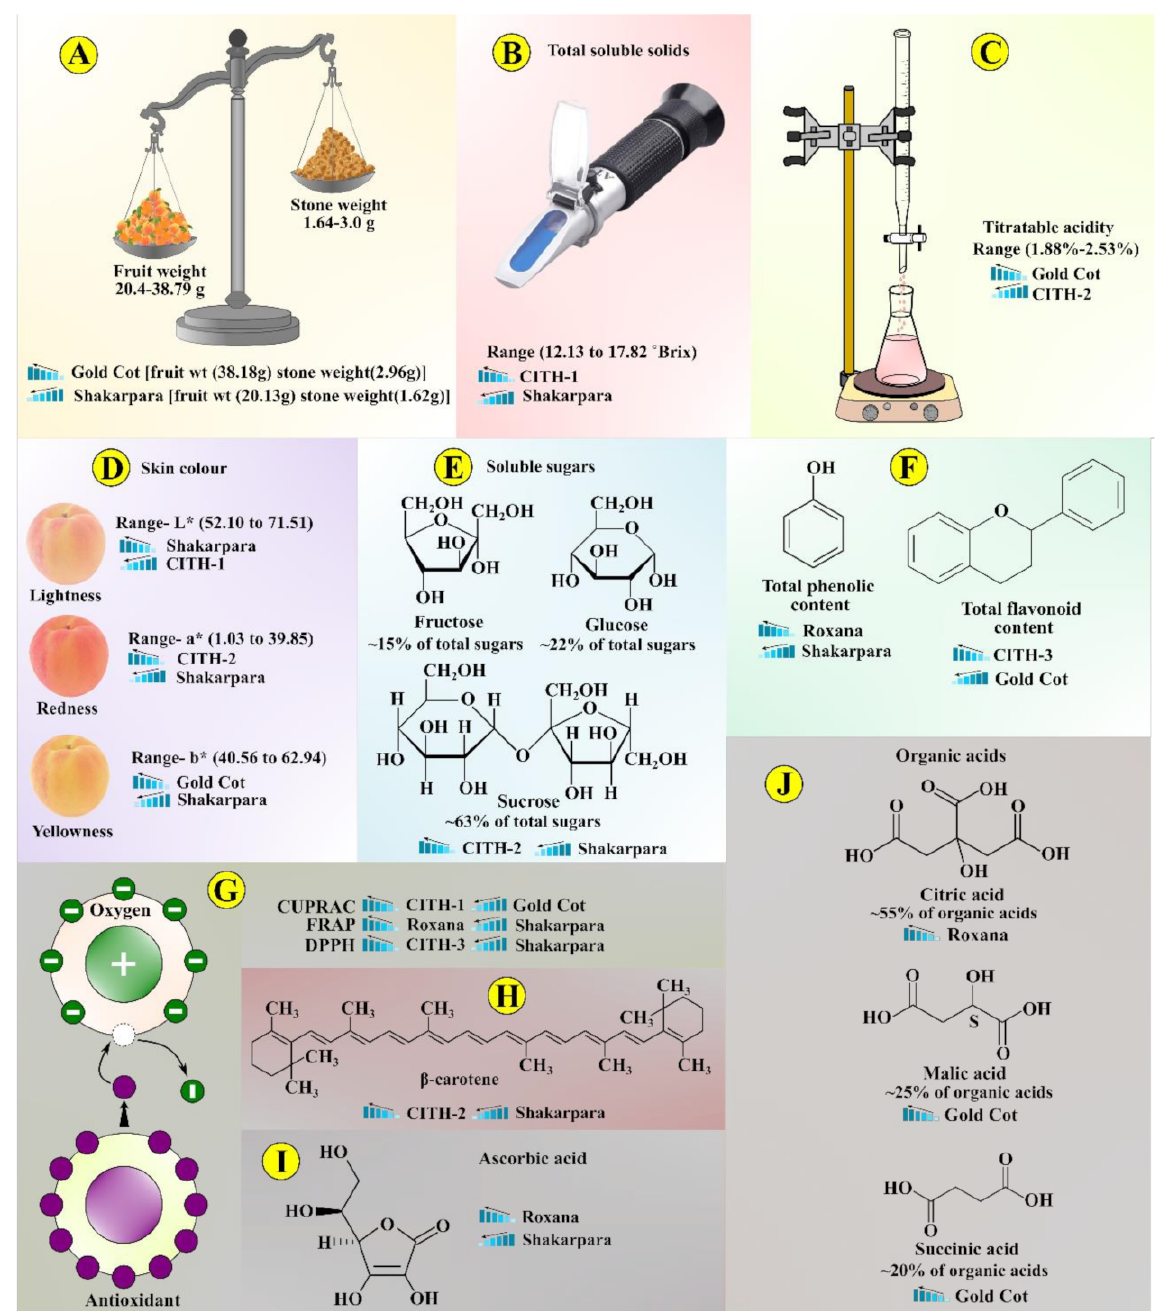
Figure 7. Graphical illustration indicating the evaluated attributes and their highest and lowest amount in the specific variety. ( A ) Fruit and stone weight; ( B ) total soluble solids; ( C ) titratable acidity; ( D ) skin colour where L* (lightness), a* (redness) and b* (yellowness); ( E ) soluble sugars; ( F ) phenolic and flavonoid content; ( G ) antioxidant activity through CUPRAC, FRAP and DPPH; ( H ) β -carotene content; ( I ) ascorbic acid content; ( J ) organic acid